Question: What type of chart is this?
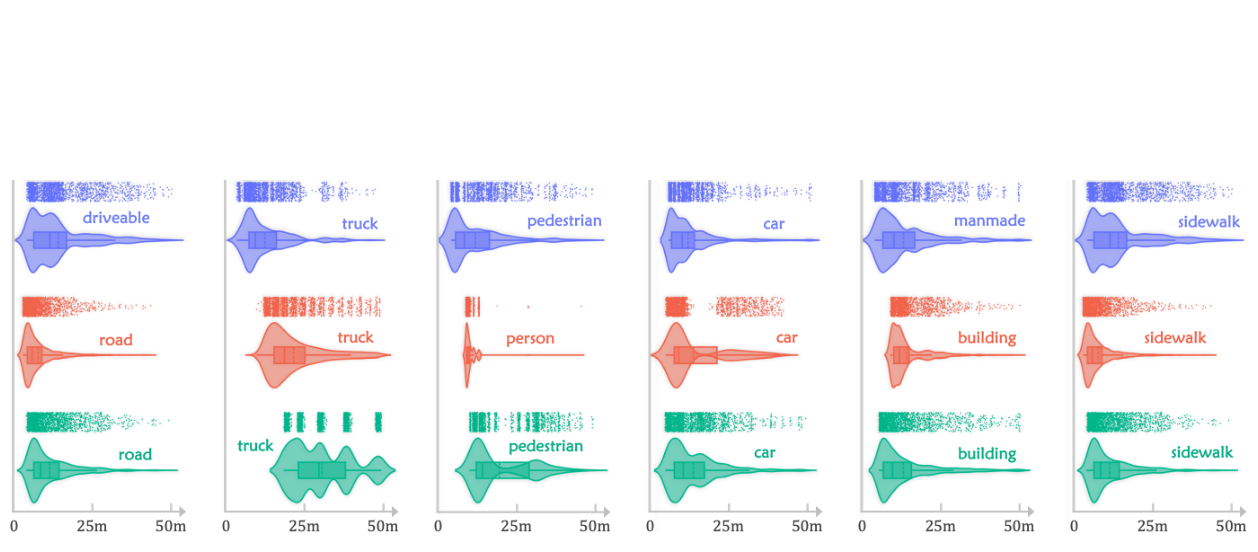
Answer: box